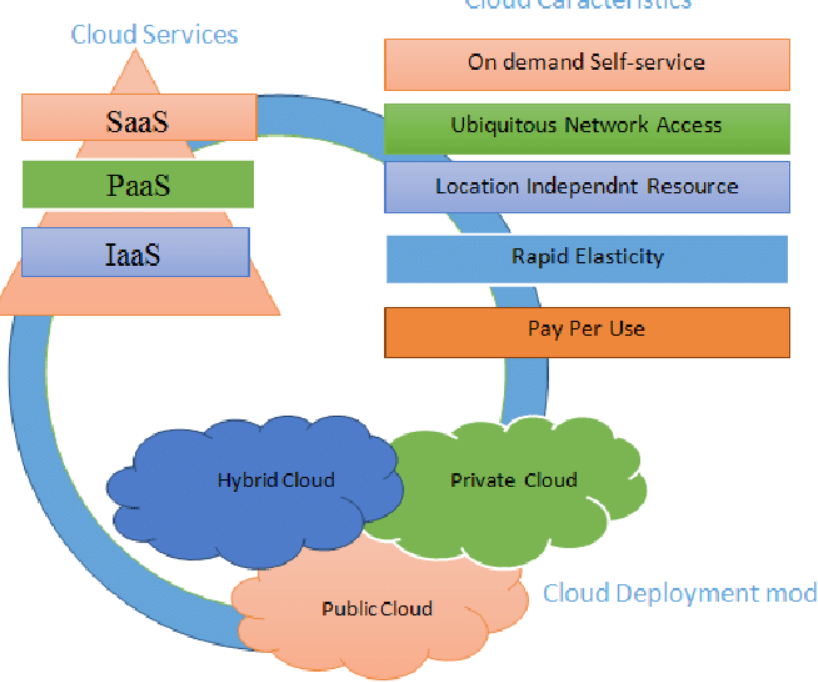
Fig. 1. Cloud computing service delivery and deployment